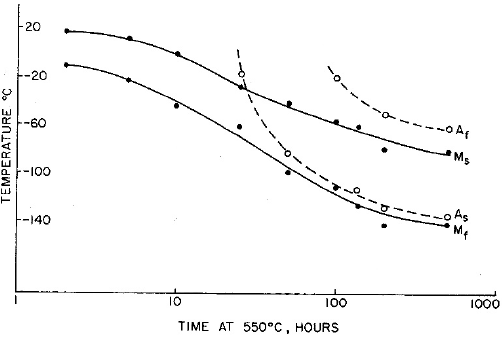
Figure 4. Transformation temperatures determined by direct observation during cold stage microscopy of Fe-24 at. %Pt alloy ordered for different times at 550 °C [11].